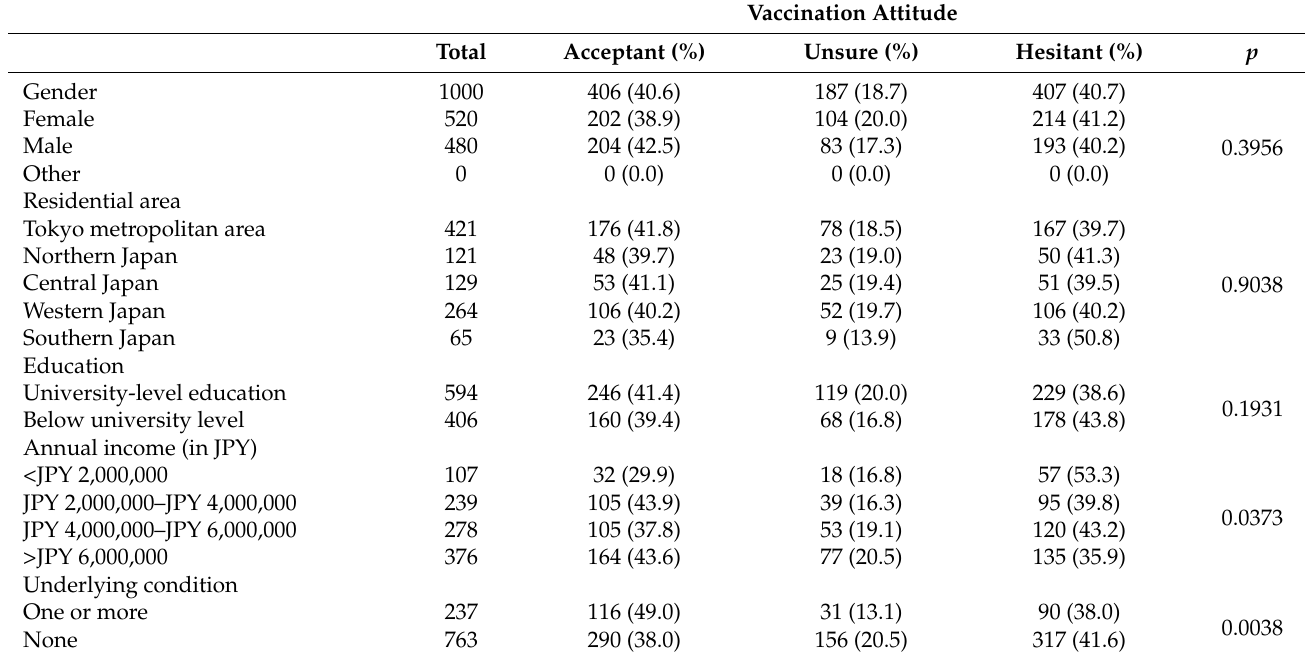
Table 1. Participants’ characteristics and vaccination attitude in April 2021.